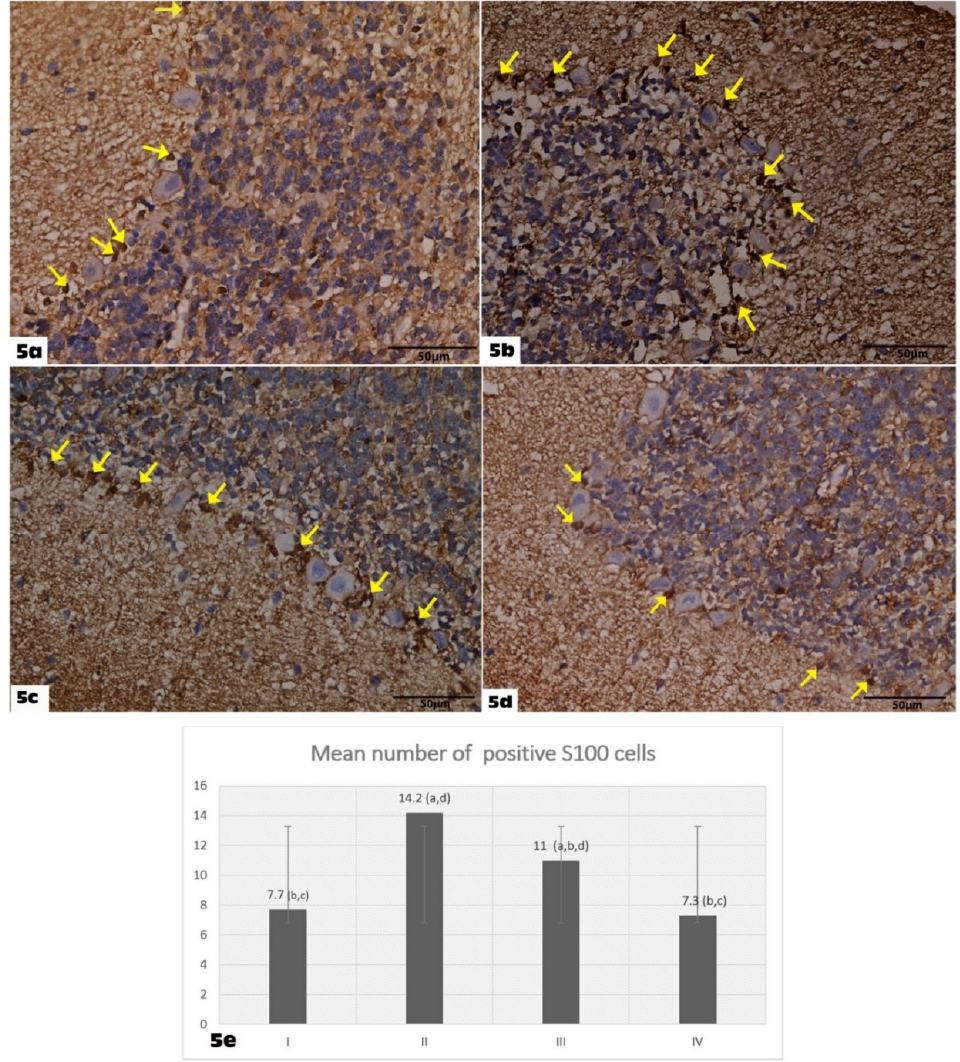
Figure 5. Shows S100 immunohistochemically stained cerebellar sections: (S100 immunostain X400) ( a ): Control group showing S100-positive cells located between the Purkinje cells (yellow arrows). ( b ): Group II showing more pronounced diffuse S100 immunostaining with a higher number of